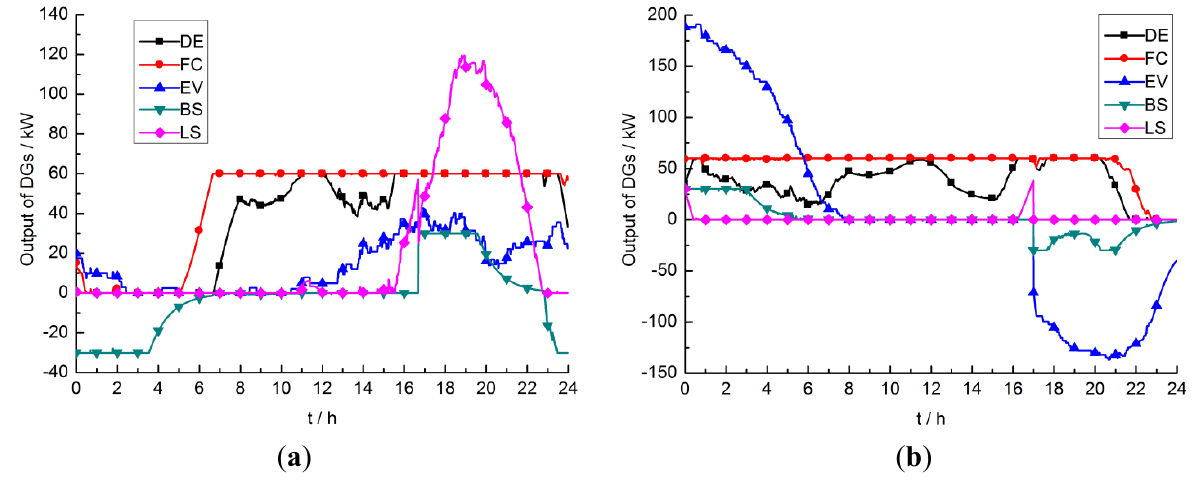
Figure 6. ( a ) Dispatch results under scheduling strategy 3; ( b ) Dispatch results under scheduling strategy